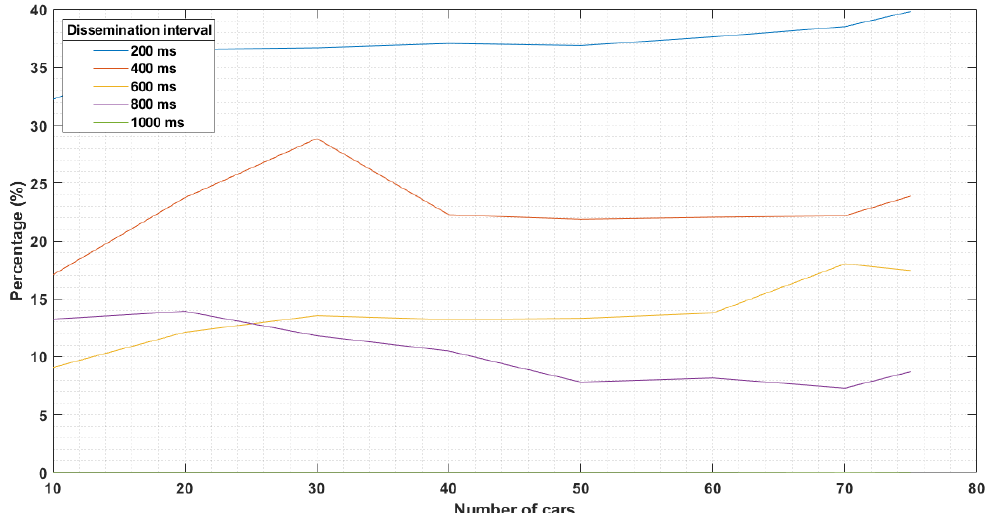
Figure 16. Throughput reduction with the application of CPM generation rules.